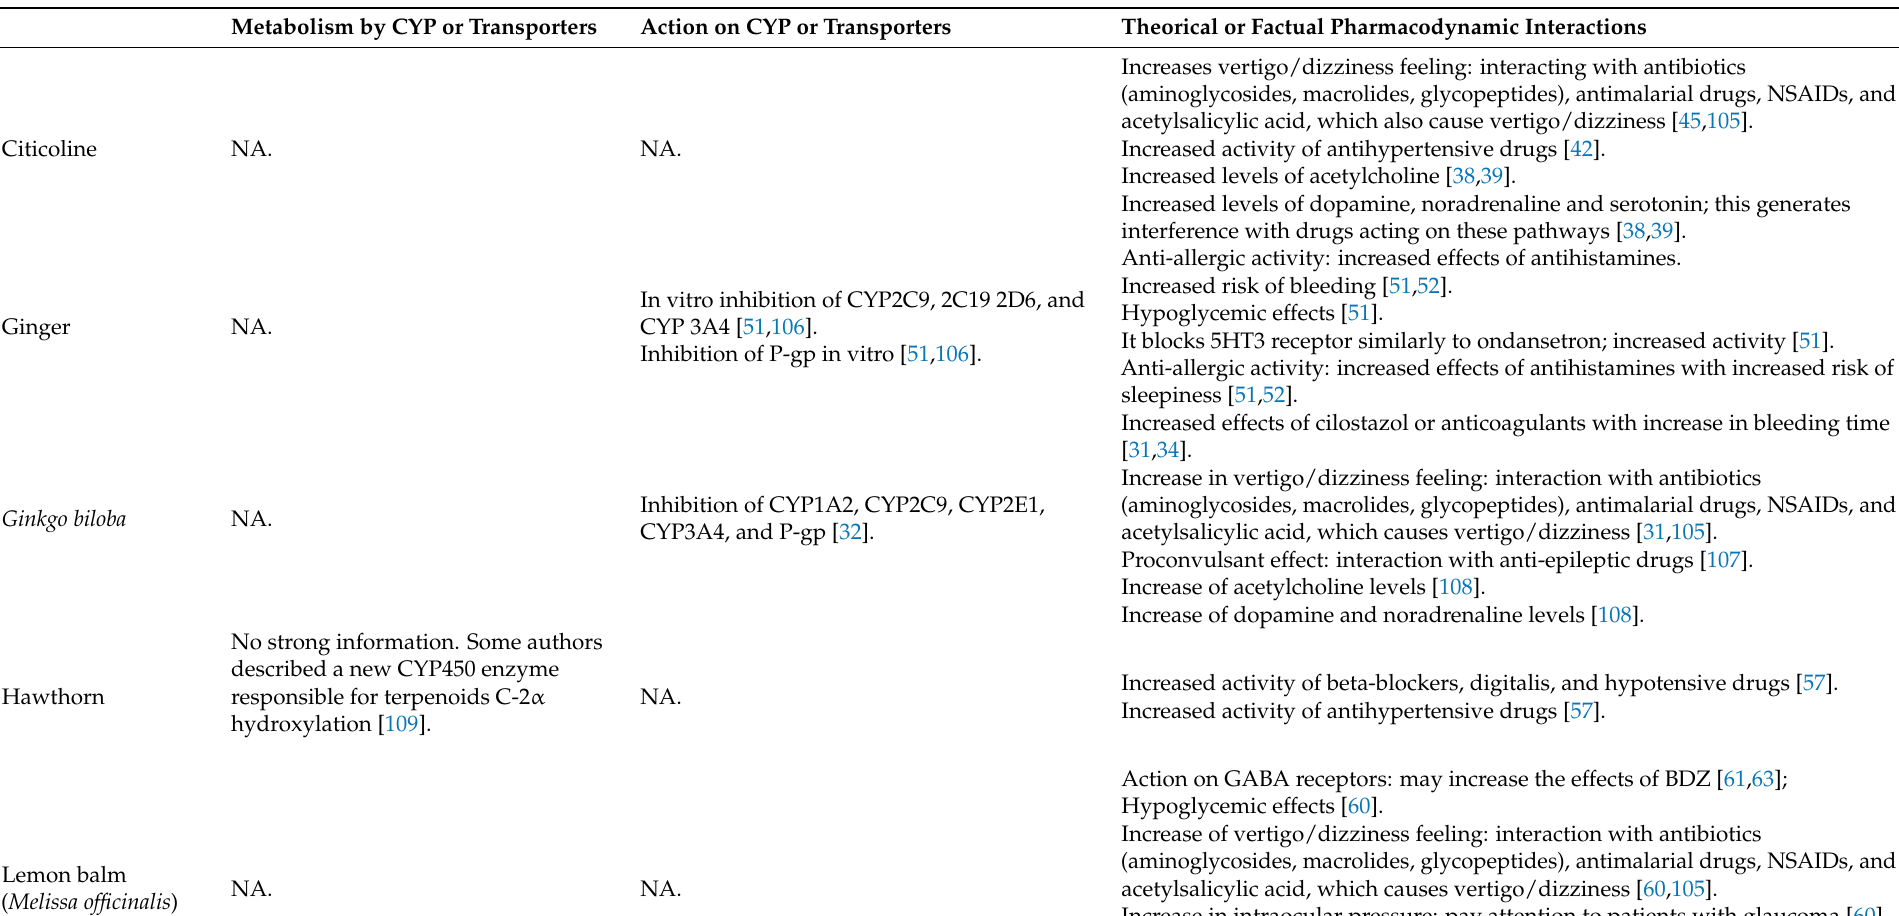
Table 3. Pharmacokinetic and pharmacodynamic interactions of nutraceuticals supplements used in the treatment of peripheral vestibular